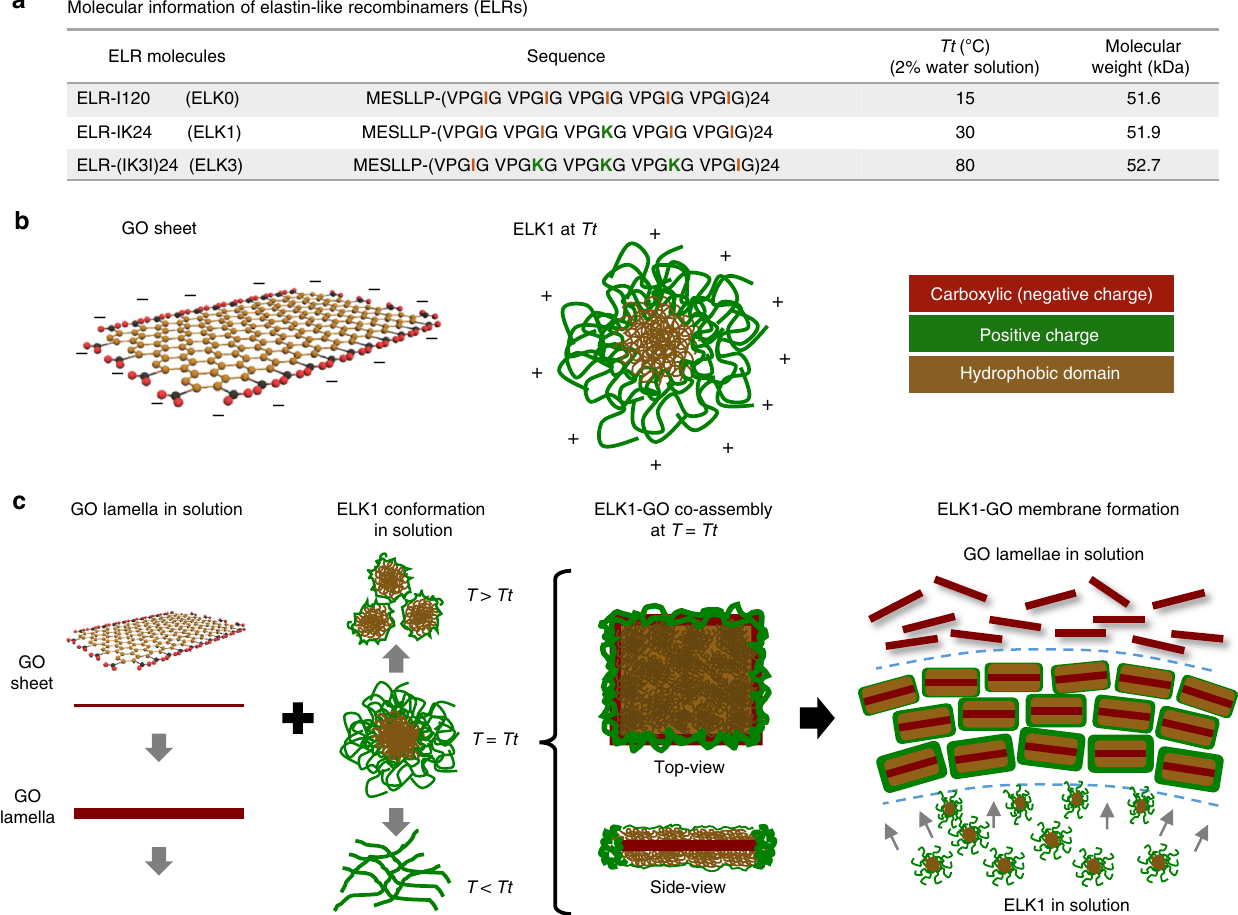
Fig. 1 Molecular building blocks and rationale for co-assembly. a Table summarizes the key information of the three elastin-like recombinamers (ELRs) used in the study comprising similar molecular weight but different levels of hydrophobicity (VPGIG) and positive charge (VPGKG). b Illustrations of the molecular structure of a GO sheet and the supramolecular organization of ELK1 at its transition temperature ( Tt ) (30 °C) indicating both the charged (red and green) and hydrophobic (brown) segments. c Schematic of the proposed mechanism of formation illustrating the molecular and supramolecular conformation of the GO and ELK1 before and after co-assembly at the ELK1 ’ s Tt as well as their interaction for membrane